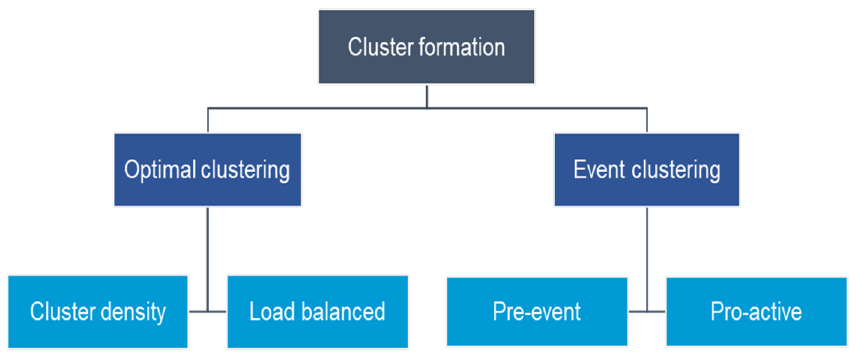
Figure 7. Cluster formation